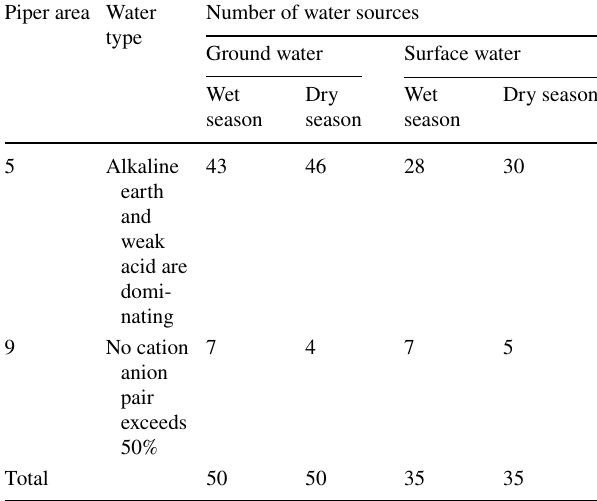
Table 14 Piper classification of water sources Piper area Water